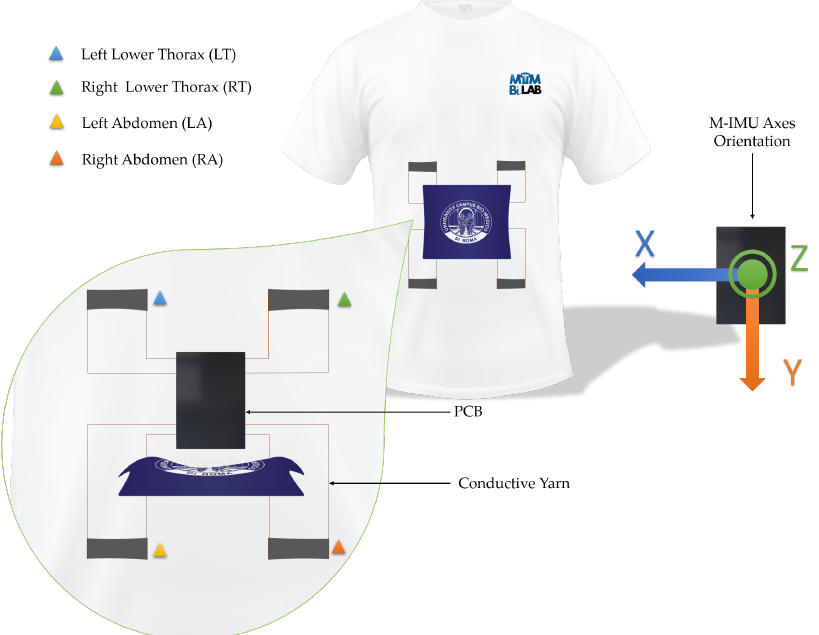
Figure 4. Graphical representation of the wearable device embedding the four sensing elements, the PCB used to collect the signals and the M-IMU